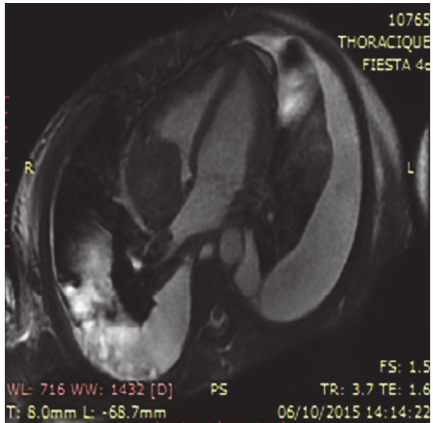
Figure 2: Cardiac MRI, thrombosis occupying most of the right atrium. Cross section of the cardiac MRI through the atria, the white ring shows the massive thrombosis at the right